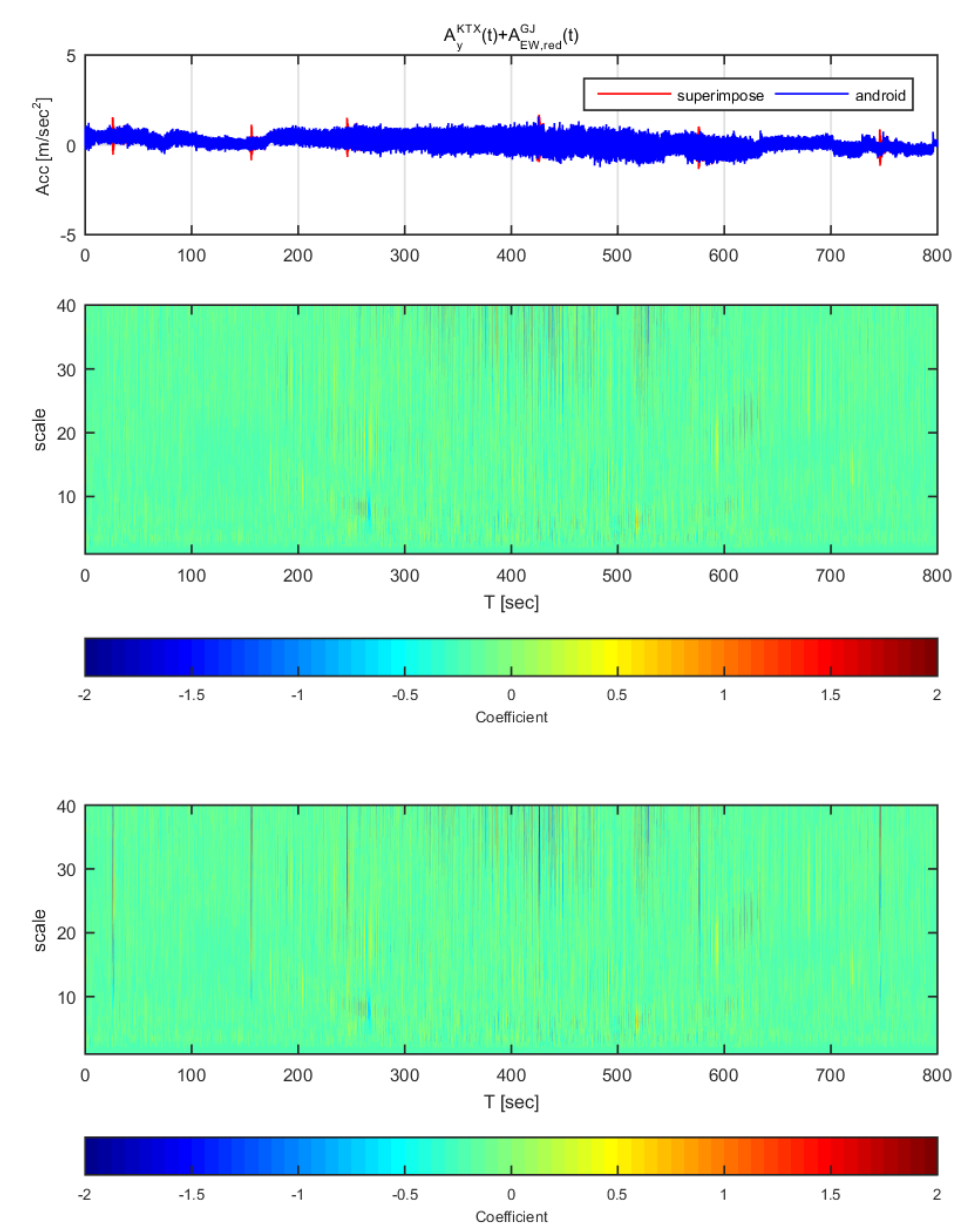
Figure 20. Wavelet transform coefficients for the combination of Korea Train Express (KTX) transverse direction data and Gyeongju earthquake east-west direction data (adjusted to 1 m/s 2 ).